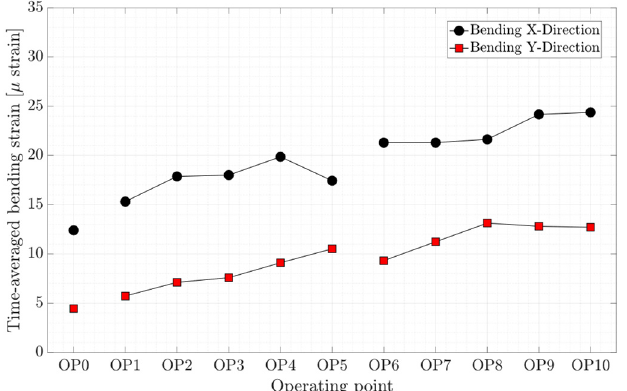
Figure 8. Time-averaged torsion strain obtained on the shaft at OP0–OP10.